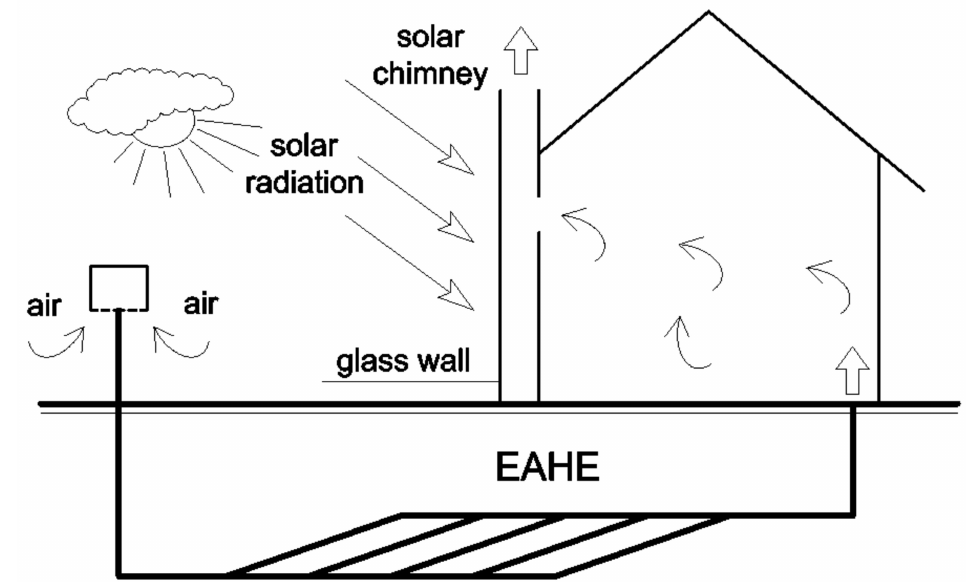
Figure 15. Schematic diagram of solar chimney (SC) coupled with earth-to-air heat exchanger (EAHE) =